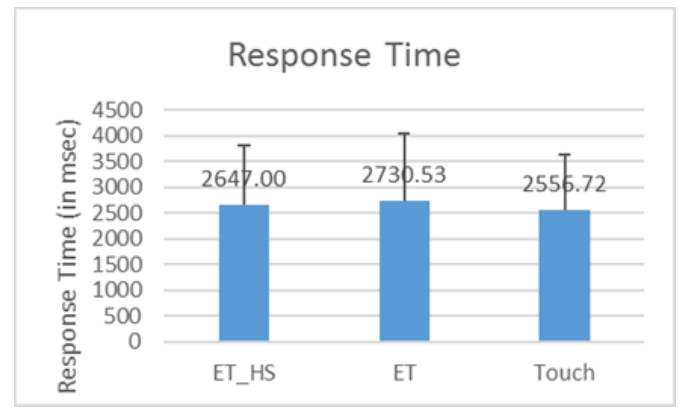
Figure 17. Comparing average response times.